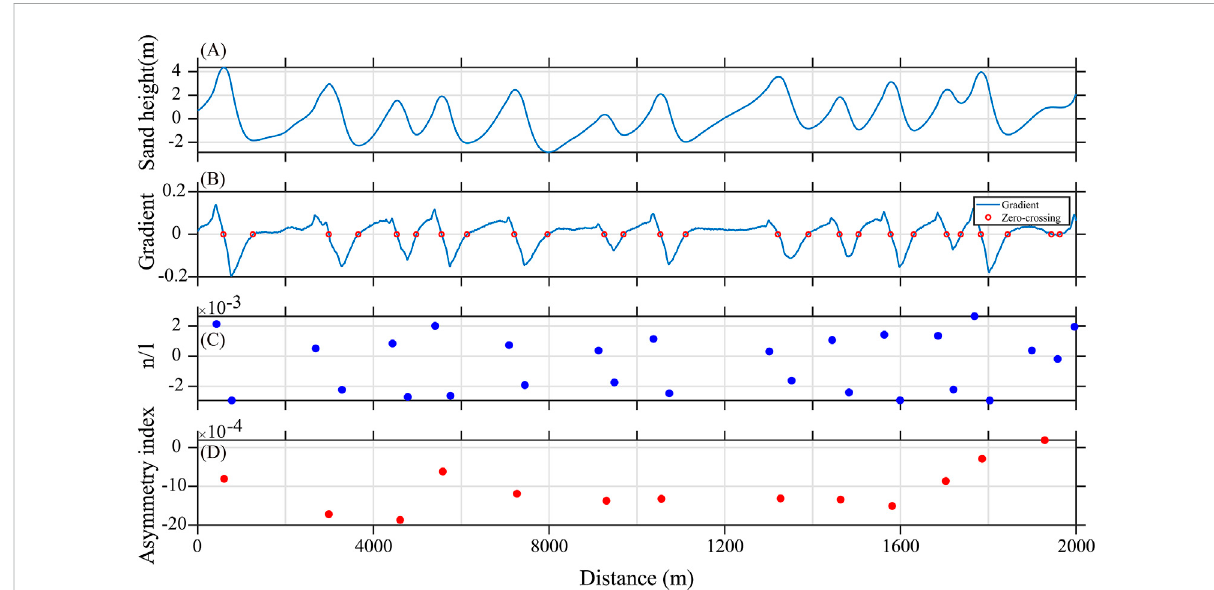
FIGURE 4 Correlation of sandwave migration direction with wave asymmetry. (A) a train of asymmetrical sandwaves from Line50. (B) the fi rst derivative (gradient) of η . (C) the ratio of n/l (height/wavelength). (D) The asymmetry index is the sum of the n/l pair for each individual sandwave. This result (negative index) show that sandwave migrated to the